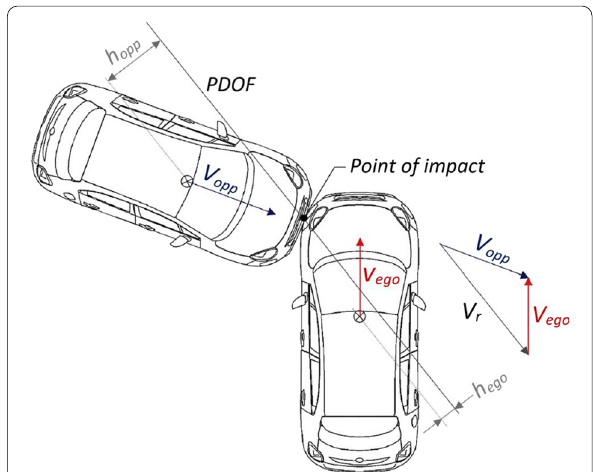
Fig. 1 Elements of a crash configuration that lead to the CMI determination (modified from Gulino et al.